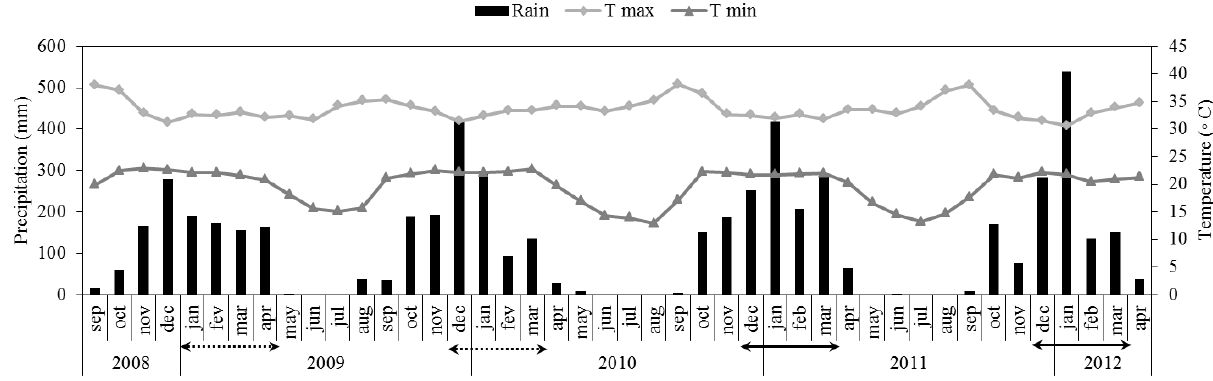
Figure 1. Monthly precipitation (Rain) and average of maxima (T max) and minima (T min) temperatures since application of biochar in the field trial in Nova Xavantina, MT, Brazil. Solid arrows indicate rice growing seasons S2 and S3. Dotted arrows represent previous seasons reported by Petter et al. (2012).